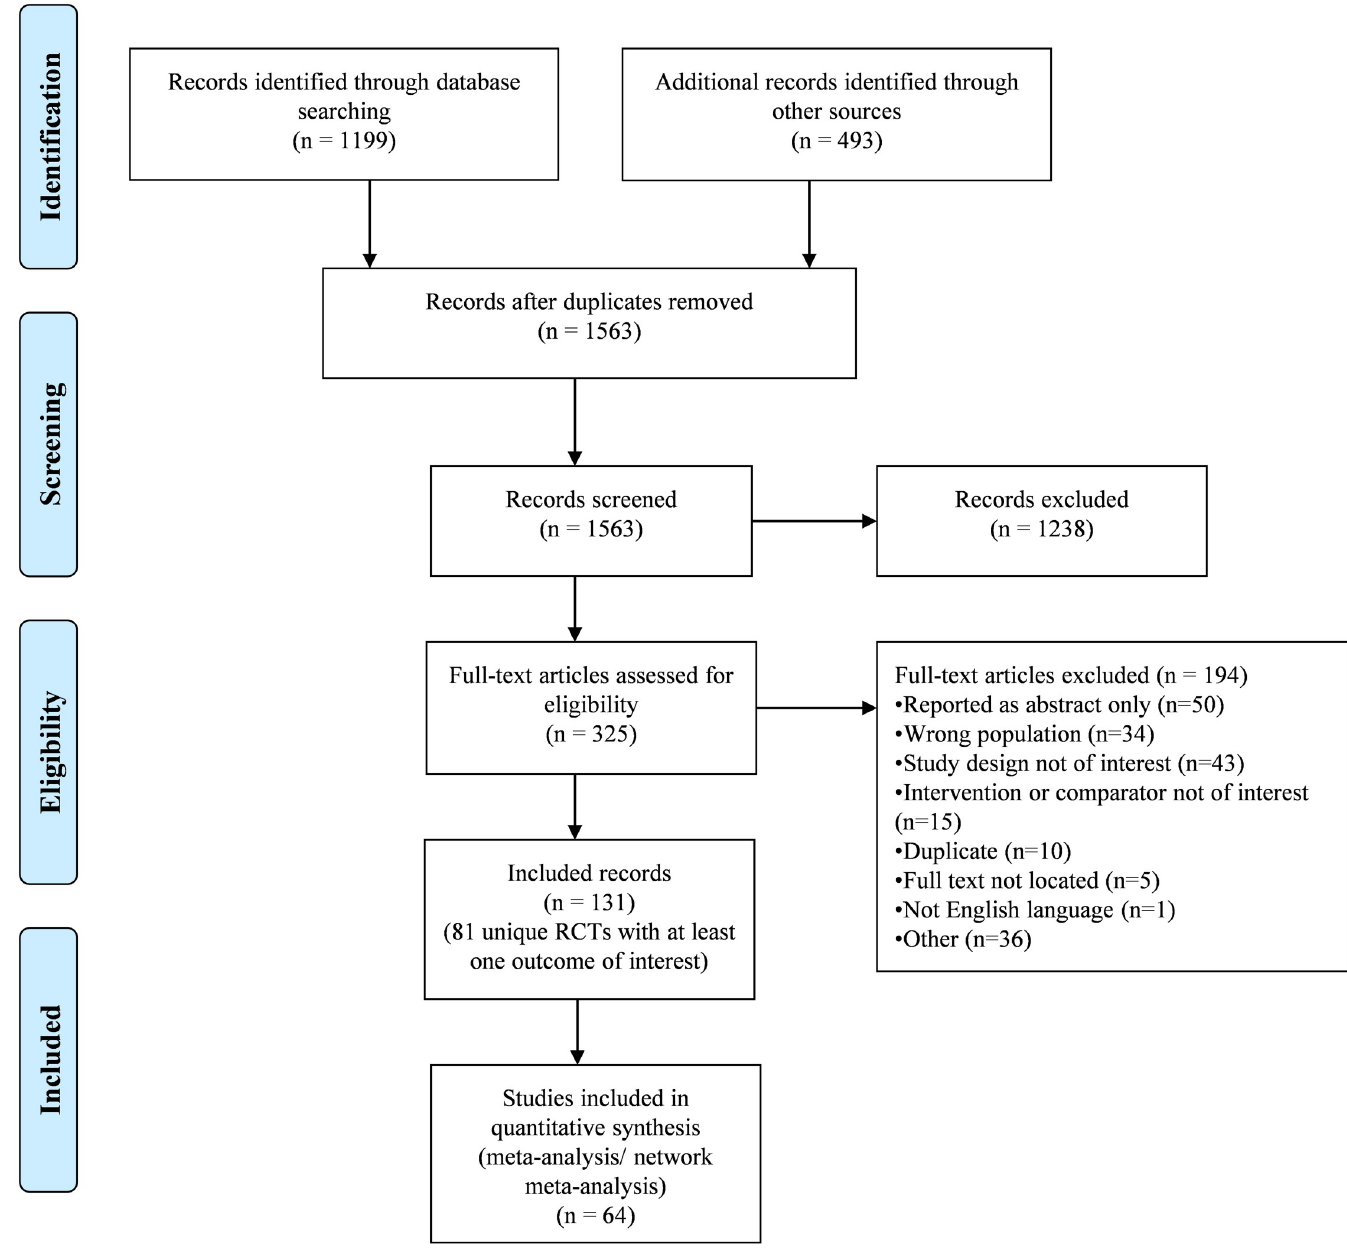
Fig 1. PRISMA flowchart of study